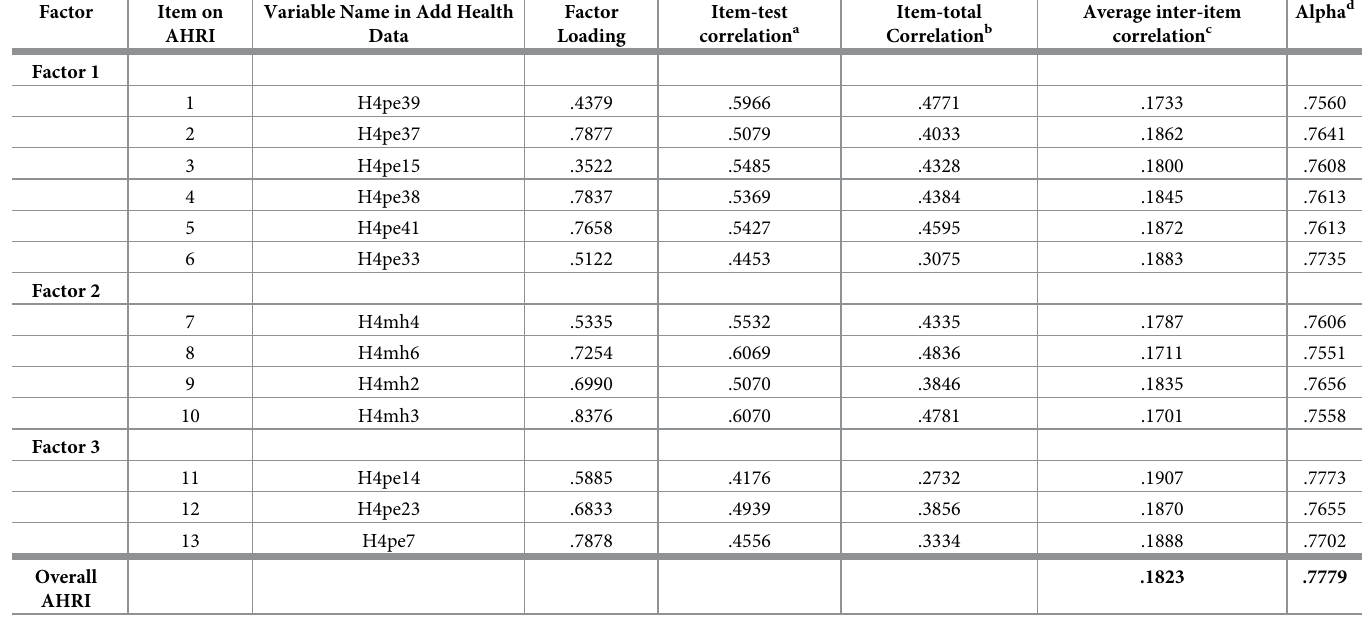
Table 2. Factor loadings and internal consistency of each item, factor and overall Add Health Resilience Instrument (AHRI).